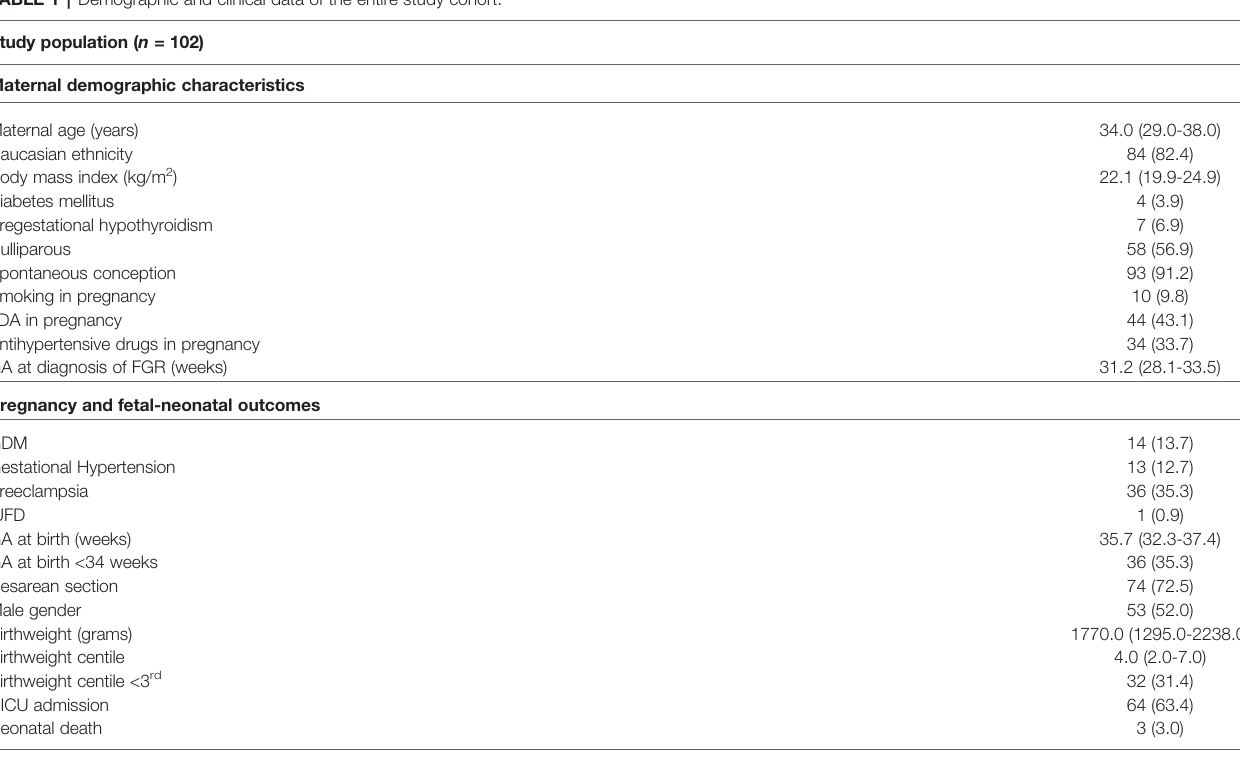
TABLE 1 | Demographic and clinical data of the entire study